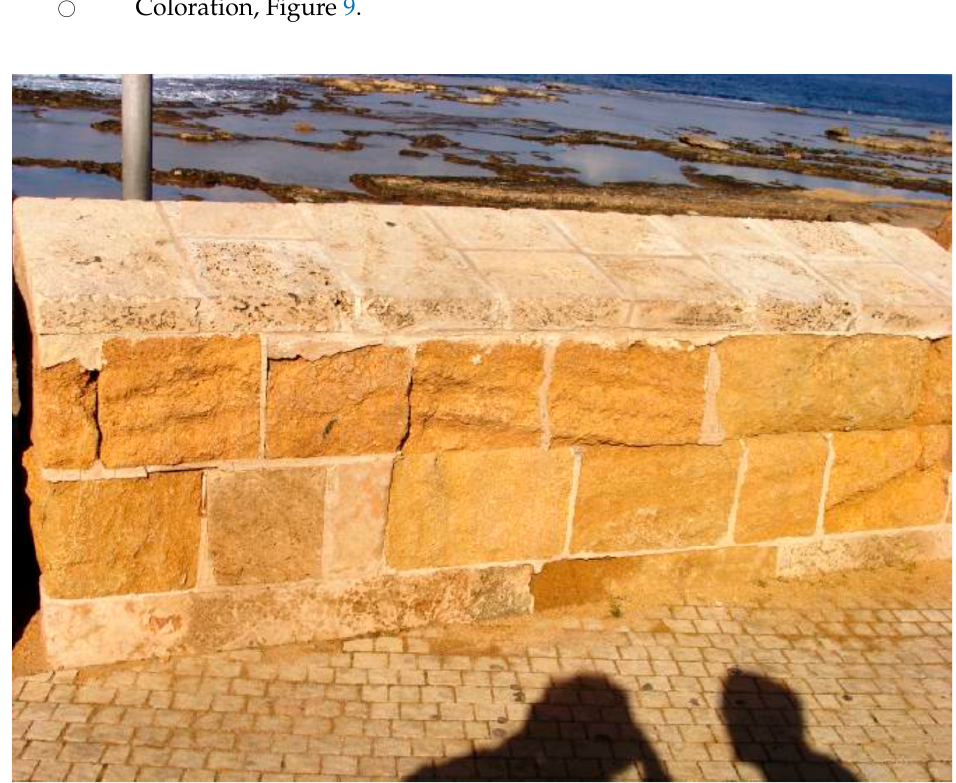
Figure 6. Back weathering of kurkar siding in the Panorama sea walls. Captured by the author on 27 November 2018.